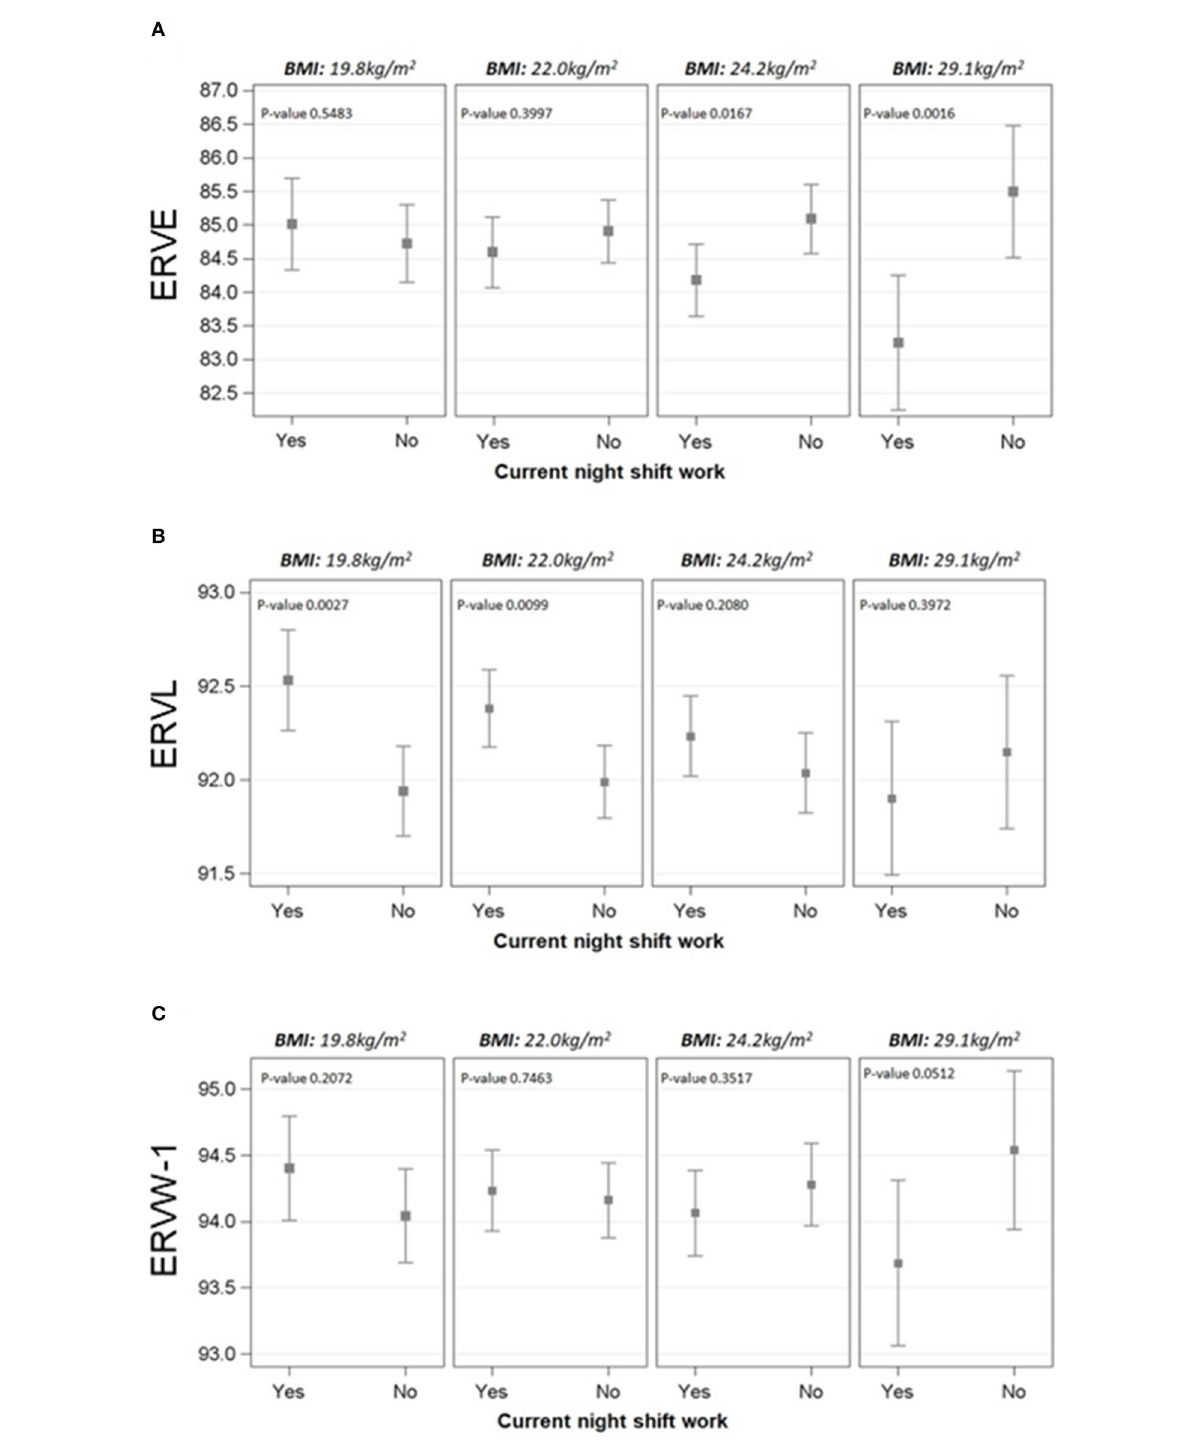
FIGURE1 Effect modification of BMI on the association between NS work and methylation of ERVE (A) , ERVL (B) , and ERVW-1 (C) . The cut-offs selected for BMI were 25th, 50th, 75th, and 95th percentile (19.8, 22.0, 24.2, and 29.1 kg/m 2 , respectively). Linear mixed regression models were adjusted for age, BMI, smoking habits, length of service with NS work, the interaction term BMI*current NS work, run, position, and their interaction. Methylation levels were calculated as marginal